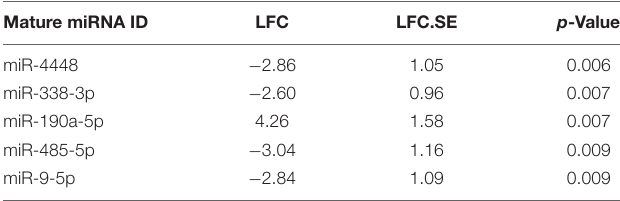
TABLE 2 | Differentially expressed miRNAs in DR serum